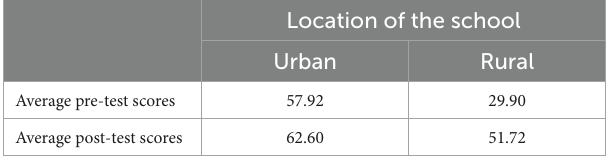
TABLE 1 Pre-test and post-test scores for rural and urban groups.